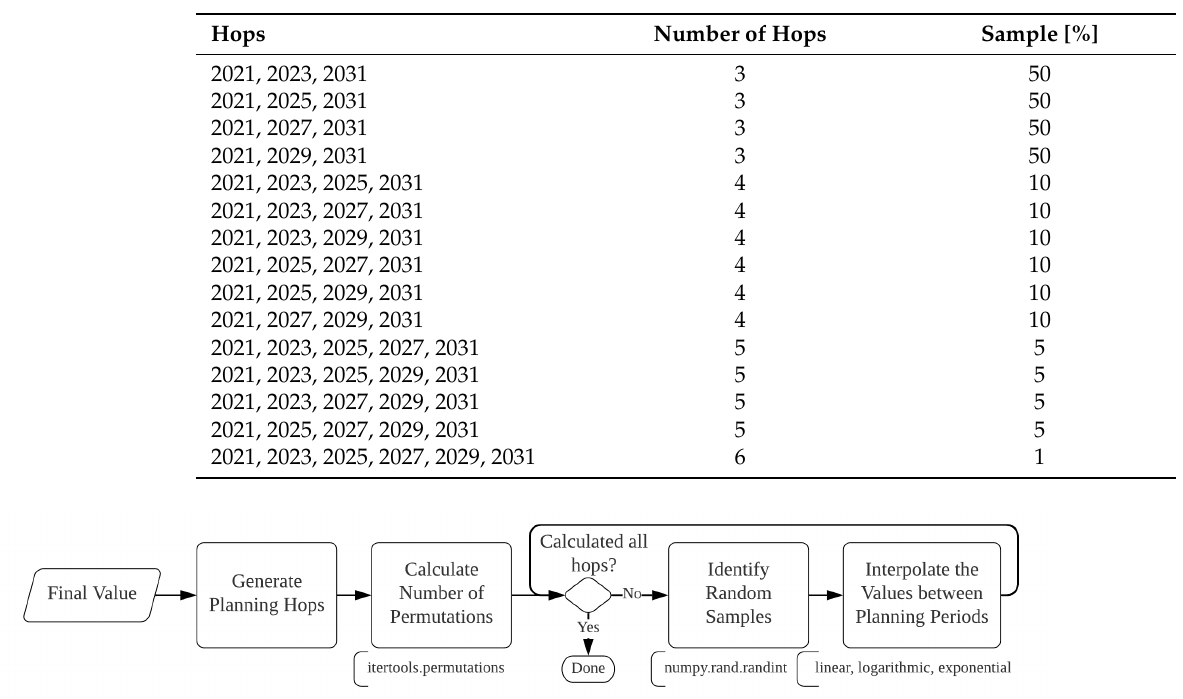
Table 3. Planning Hops.